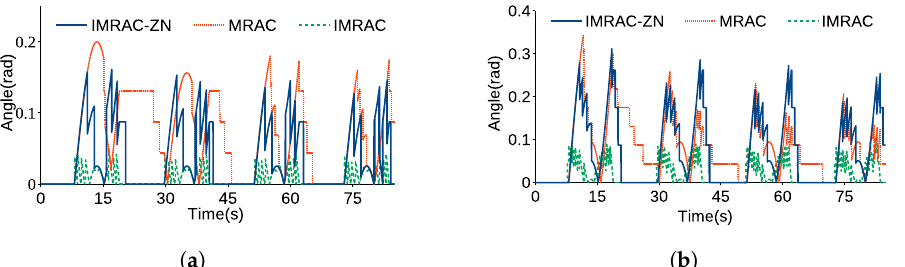
Figure 9. Comparison of an angular trajectory error for MRAC, IMRAC-ZN, and IMRAC. ( a ) hip; and ( b ) knee.